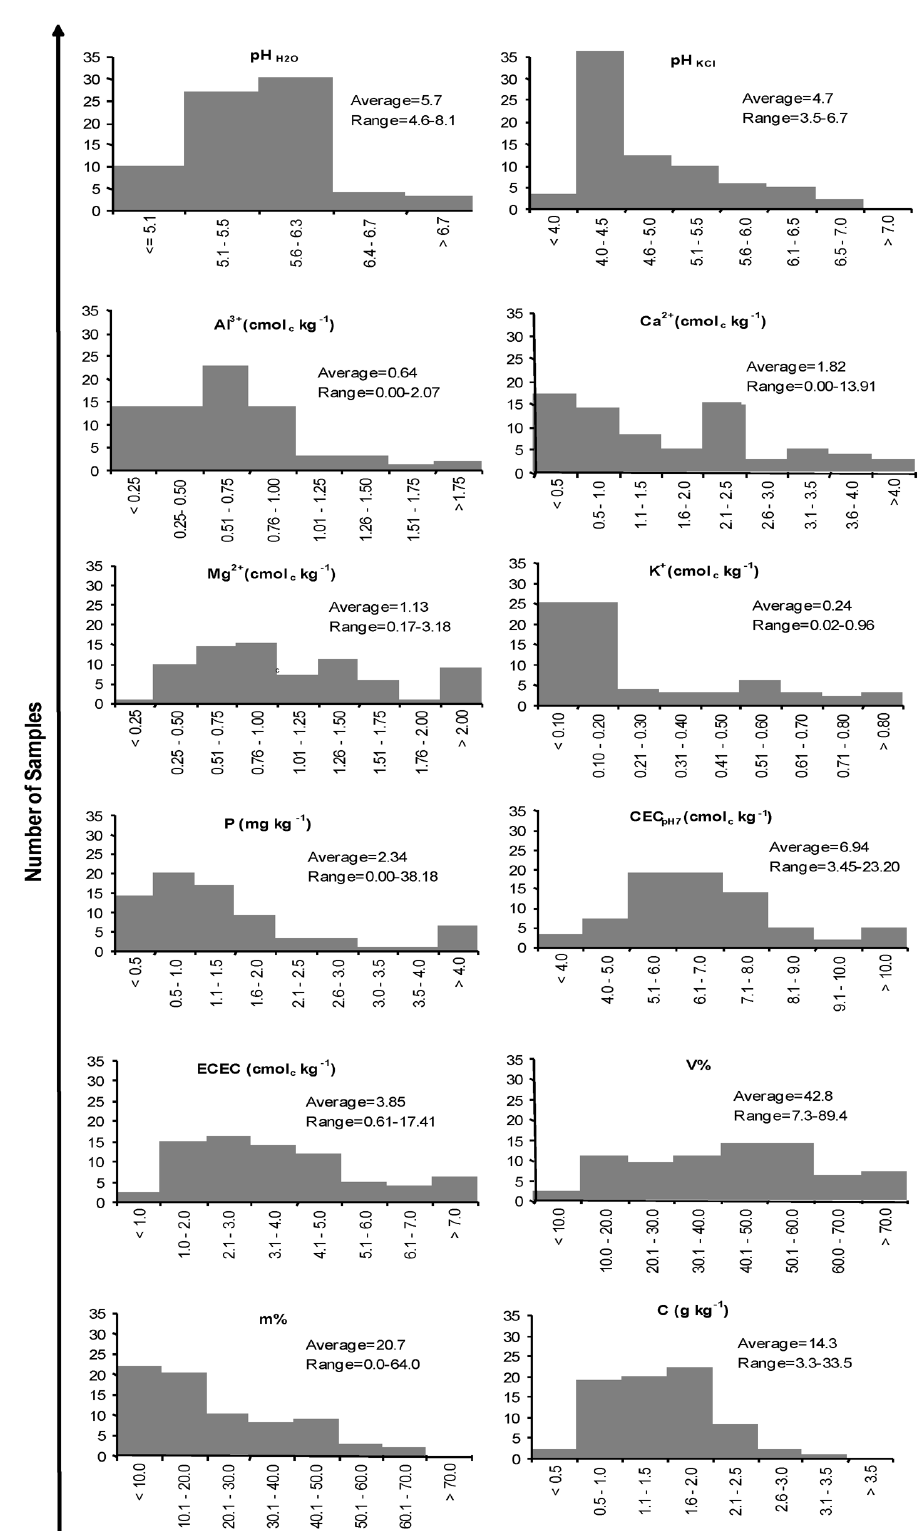
Fig. 2 – Classes and frequency distribution of the chemical characteristics evaluated in the 0.0–0.2 m horizon of Latossolos under pasture in the Brazilian Cerrado